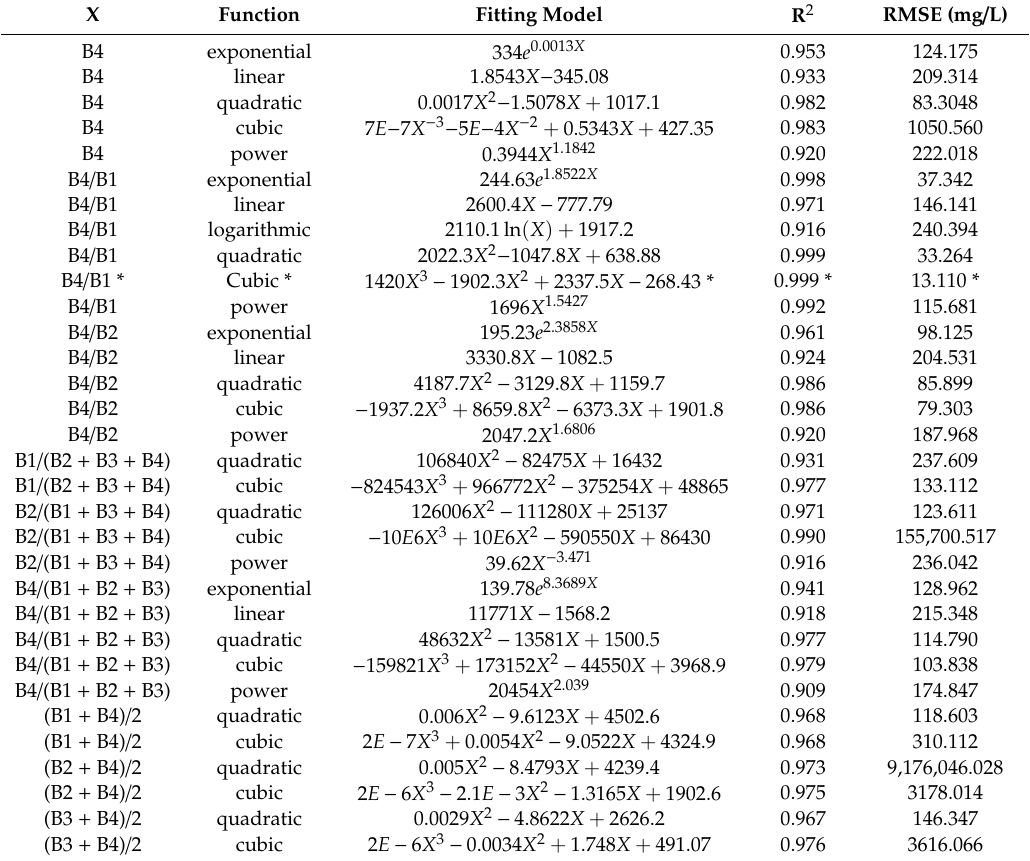
Table 4. Fitting models with correlation coe ffi cient (R 2 ) higher than